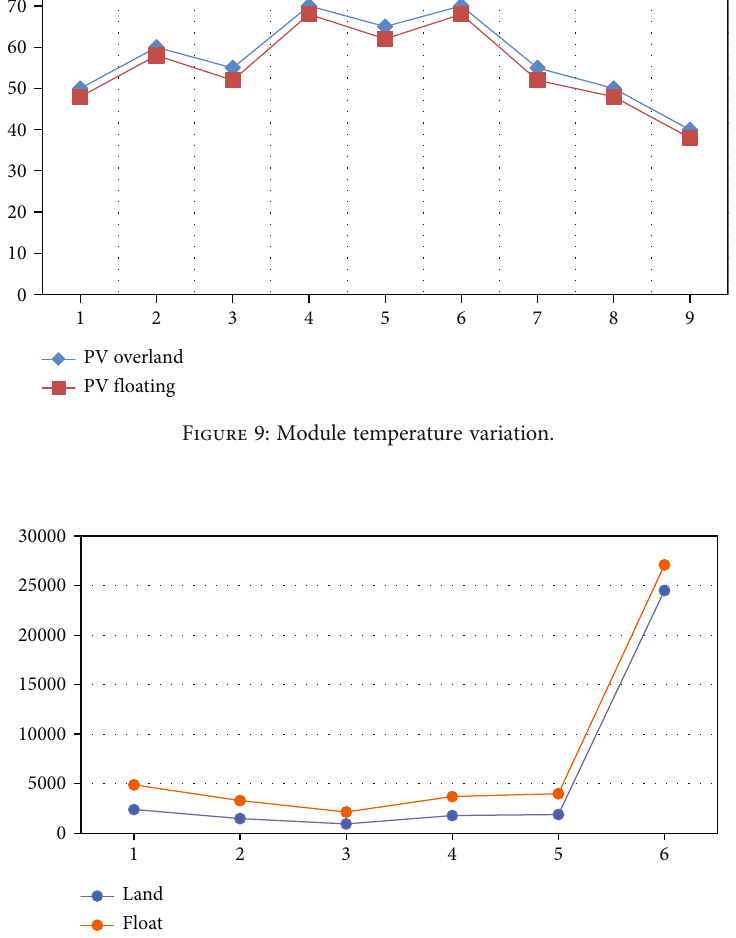
Figure 10: Comparison of land and fl oating PV